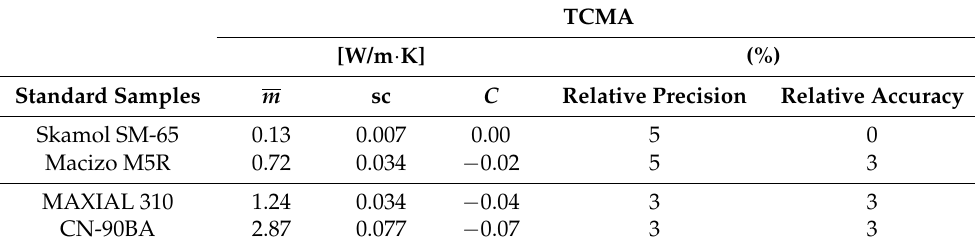
Table 7. Values obtained during the calibration of the